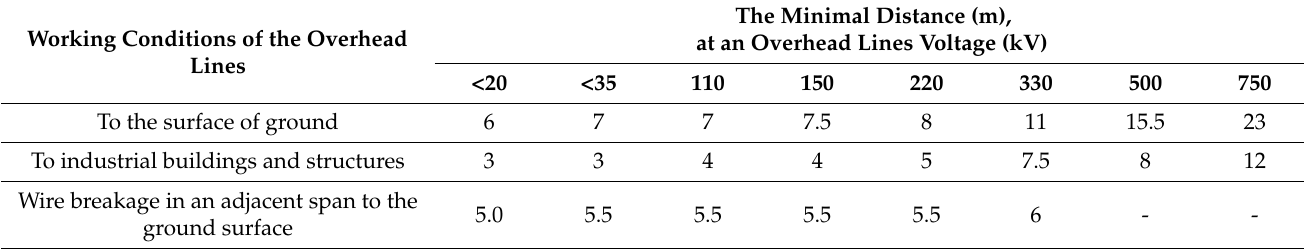
Table 5. Minimal vertical distance between overhead wires and the ground surface and industrial buildings and structures in a populated area.